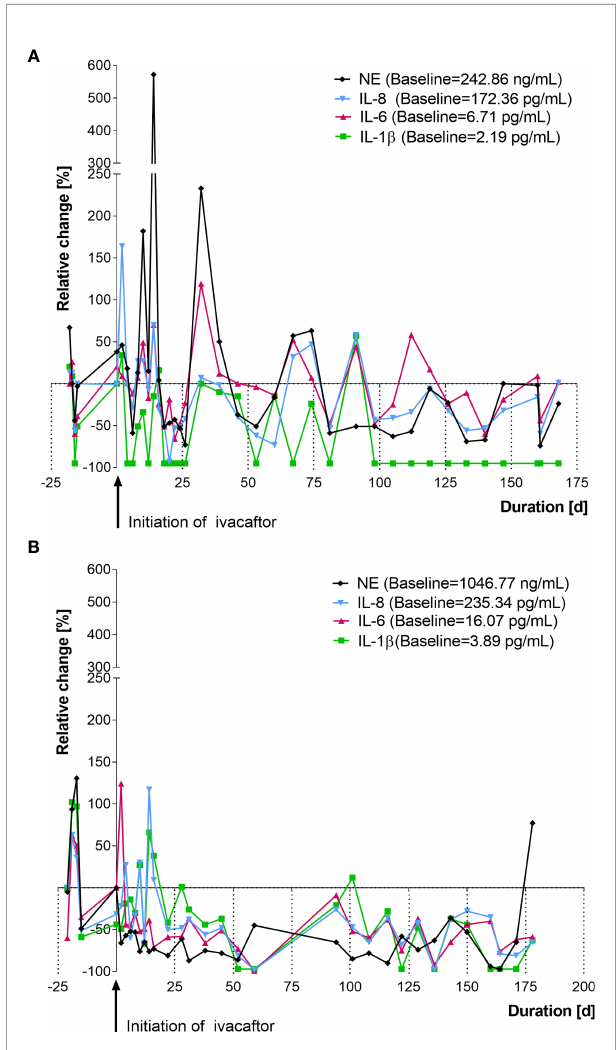
FIGURE 2 | Changes in cytokines in nasal lavage after initiation of ivacaftor therapy (day 0) in two representative CF patients with a G551D mutation. (A) female, age: 27 years, follow up: 5.7 months. (B) male, age: 32 years, follow up: 5.8 months, values shown are relative changes to median of 5 [both (A, B) ] measurements prior to ivacaftor. NE, neutrophil elastase; IL,